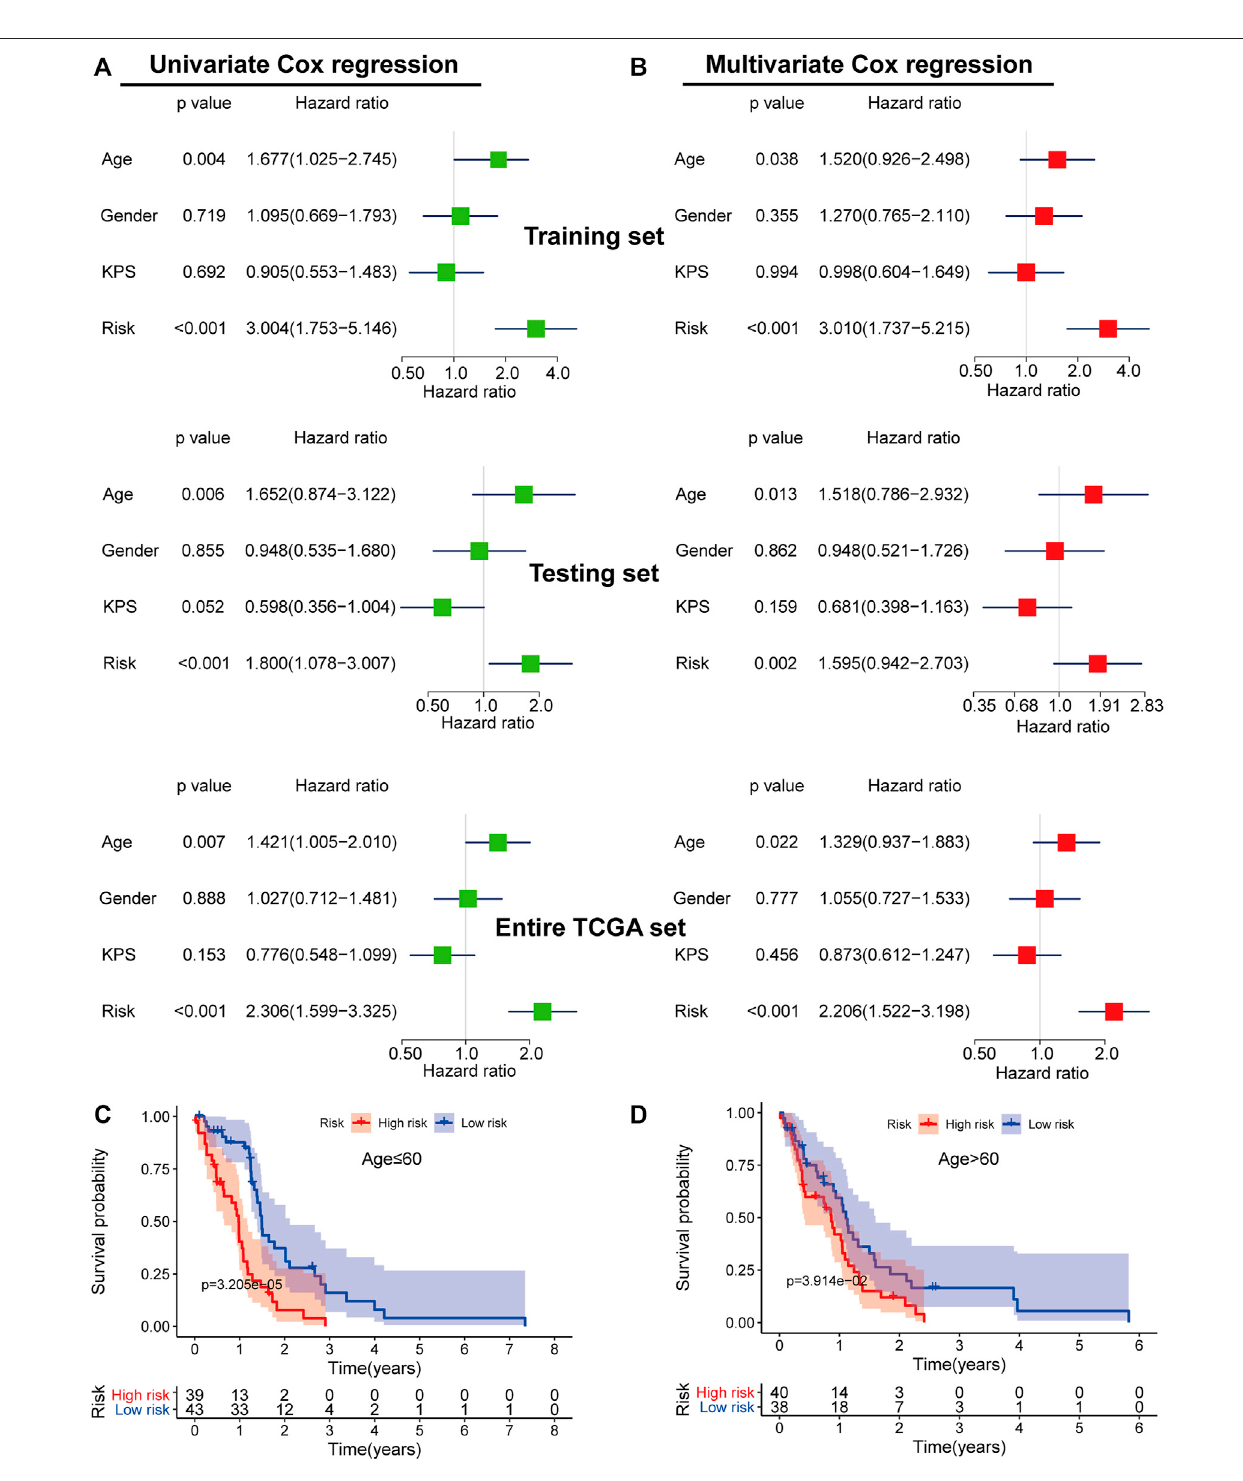
FIGURE 8 | The independence of the prognostic value of the fi ve-mRNA signature from clinical characteristics. Univariate (A) and multivariate (B) Cox regression analyses of the correlation between GBM patient overall survival (OS) and clinical characteristics (age, gender, and Karnofsky Performance Score (KPS)). Kaplan – Meier survival curve analysis of OS in the high- and low-risk groups for young patients ( ≤ 60 years old) (C) and old patients ( > 60 years old) (D) .